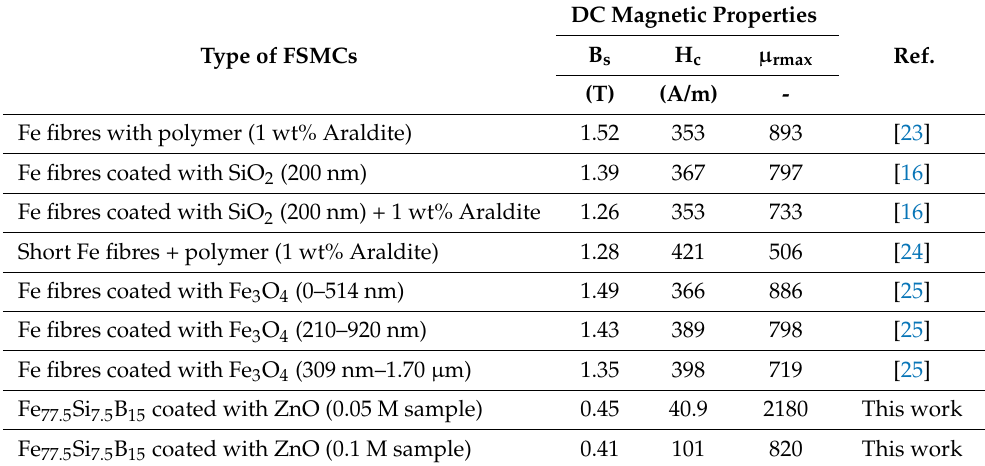
Table 1. Comparison between the DC magnetic properties reported up to now for FSMCs prepared via classic routes and cold